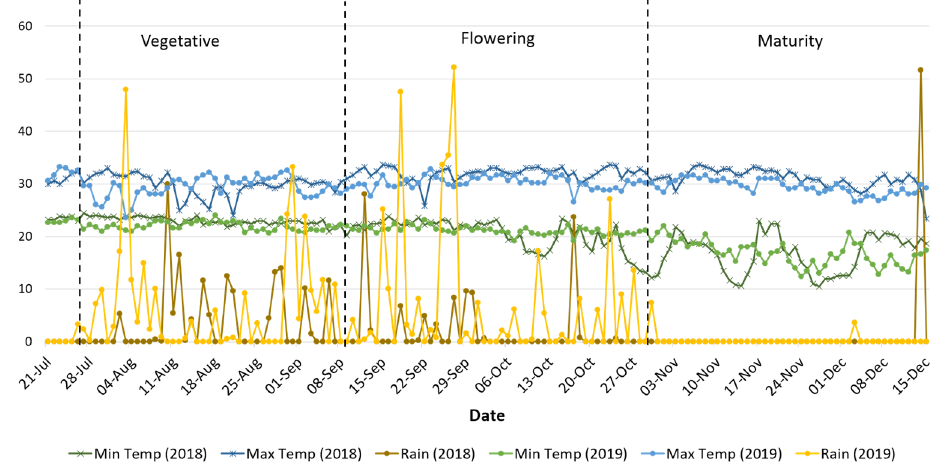
Figure 1. Weather parameter data of 2018 and 2019 rainy seasons during the finger millet crop growth stages.